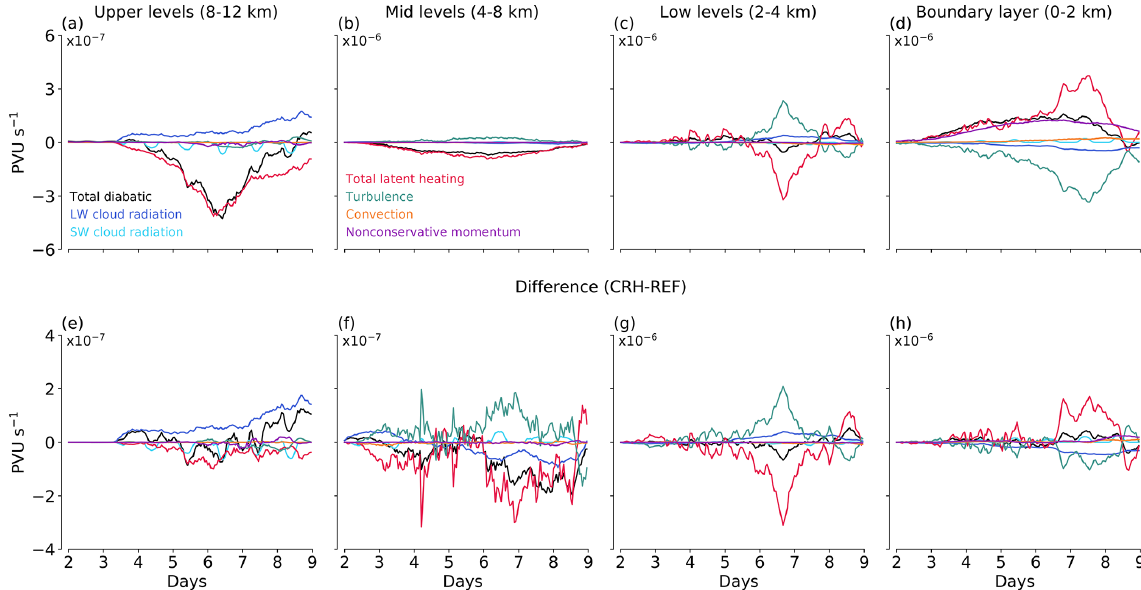
Figure 8. Evolution of spatially averaged and mass-weighted vertical average of diabatic PV tendencies between (a) 8–12km, (b) 4–8km, (c) 2–4km and (d) 0–2km in the CRH simulation. Panels (e) – (h) show the differences between the CRH and REF simulations (CRH–REF). Note the different y axes in the panels. Total diabatic PV tendency (black line) is the sum of the individual diabatic PV tendencies shown as colored